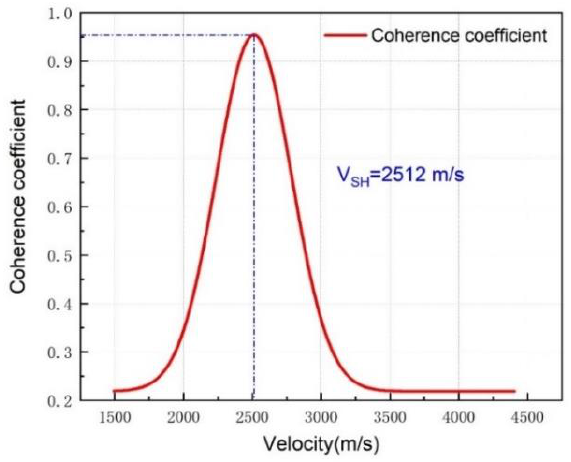
Figure 10. Acoustic field velocity-coherence coefficient fitting curve.